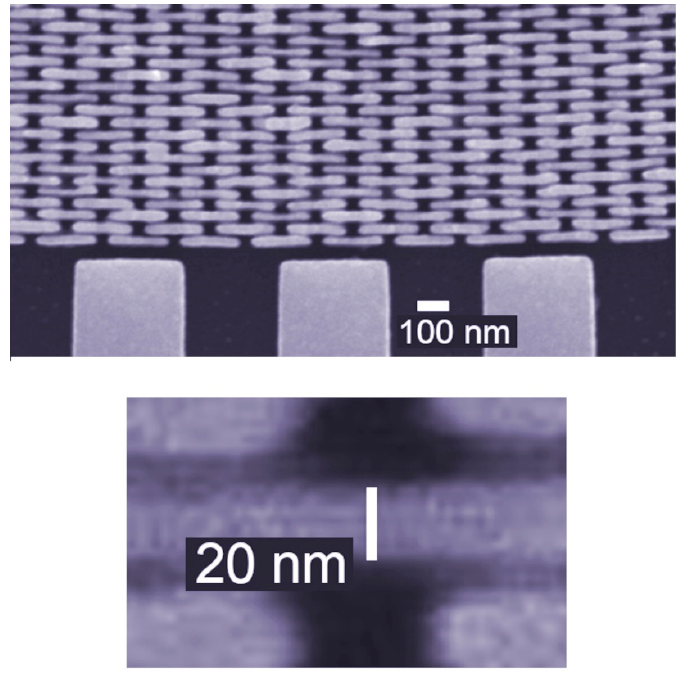
Figure 14. Micrograph showing the outermost zones of an X-ray FZP, with a zone width as small as 20 nm [18–24]. Also shown is the external support structure.